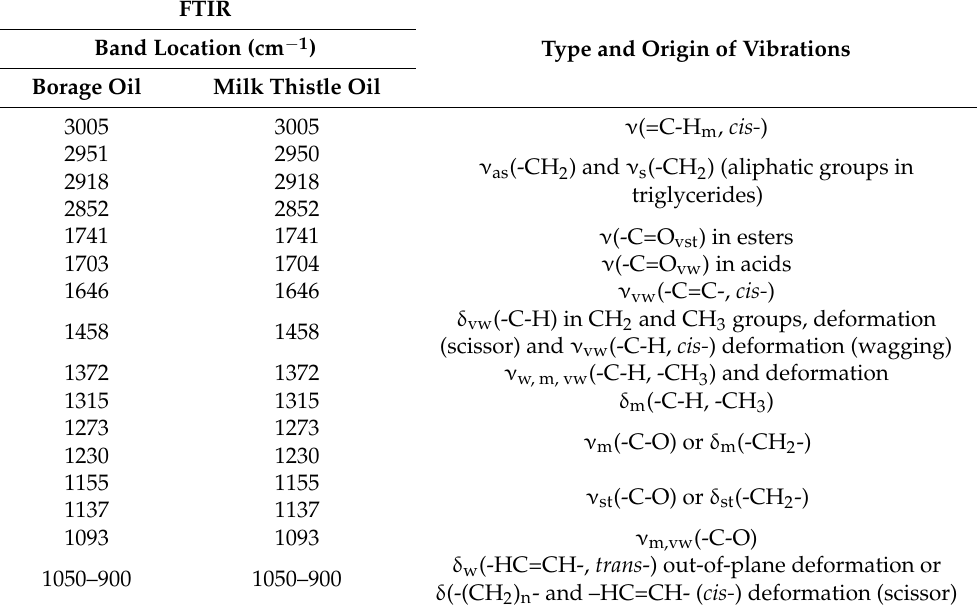
Table 9. Locations of FTIR absorption band maxima and assignment of particular vibrations to the respective samples, borage oil and milk thistle oil, registered within the spectral range of 800–3200 cm − 1